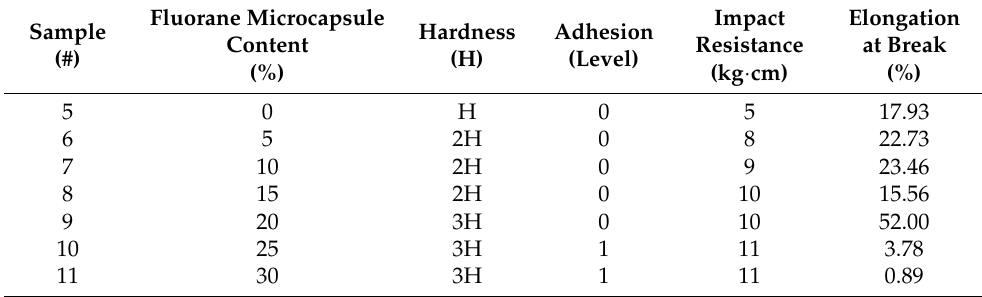
Table 6. Effect of fluorane microcapsule concentration on mechanical